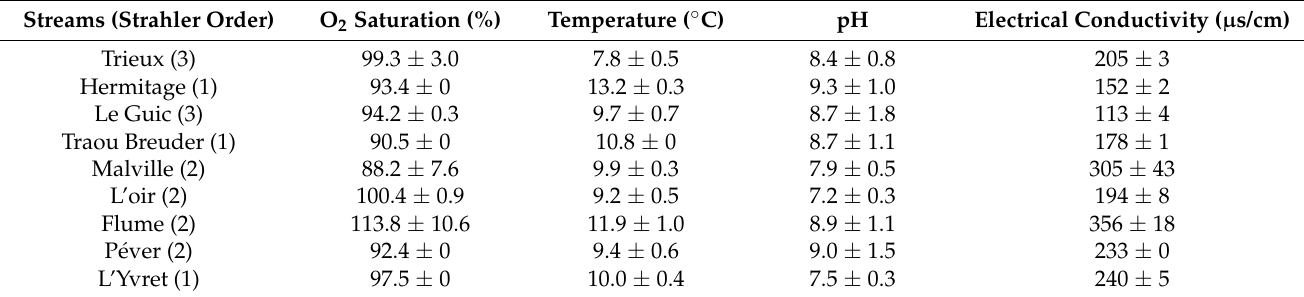
Figure 1. Maps of ( a ) France with administrative regions, and ( b ) the study area showing the localizations of the nine streams. Black lines represent stream networks. Table 1. Mean (±SE) values of the physico-chemical characteristics of the nine streams (number between brackets corresponds to the stream order) during the leaf litter experiment.